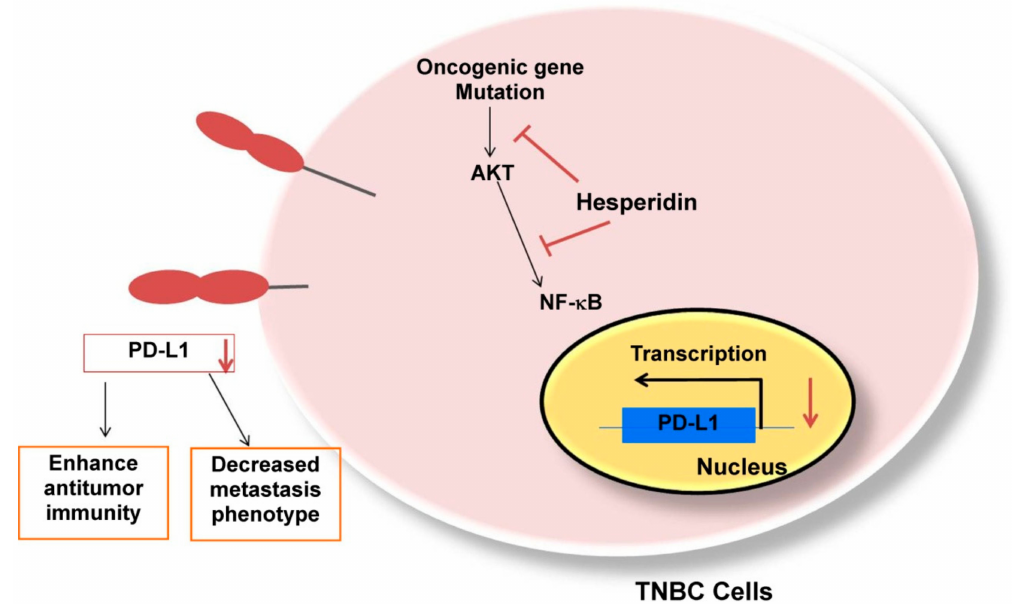
Figure 6. Proposed model of hesperidin suppressing Akt and NF- κ B activation that mediated PD-L1 mRNA and protein expression. Second, hesperidin inhibited the migration and MMP-9 and MMP-2 secretion in MDA-MB231